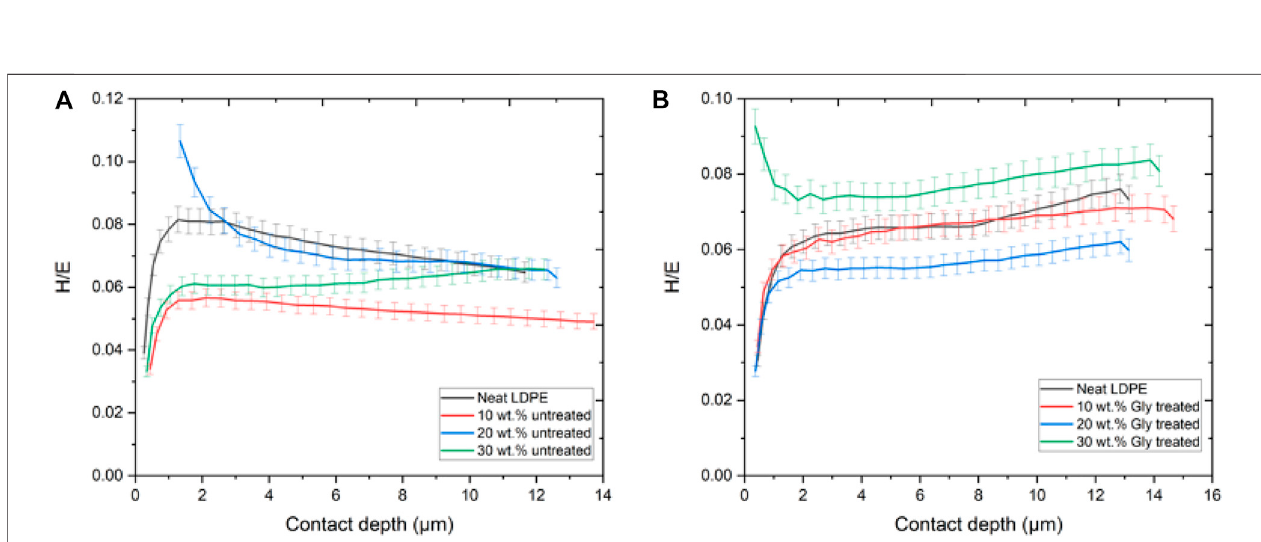
FIGURE 9 | Plasticity index (H/E) of biocomposites as a function of contact depth: (A) plasticity index of untreated biocomposites; (B) plasticity index of treated biocomposites.